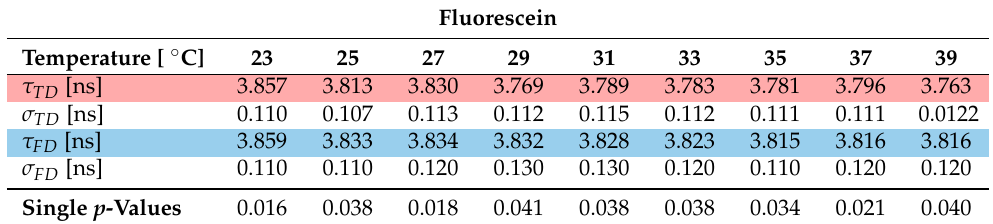
Table 5. P-values and obtained lifetimes for the temperature series of fluorescein.